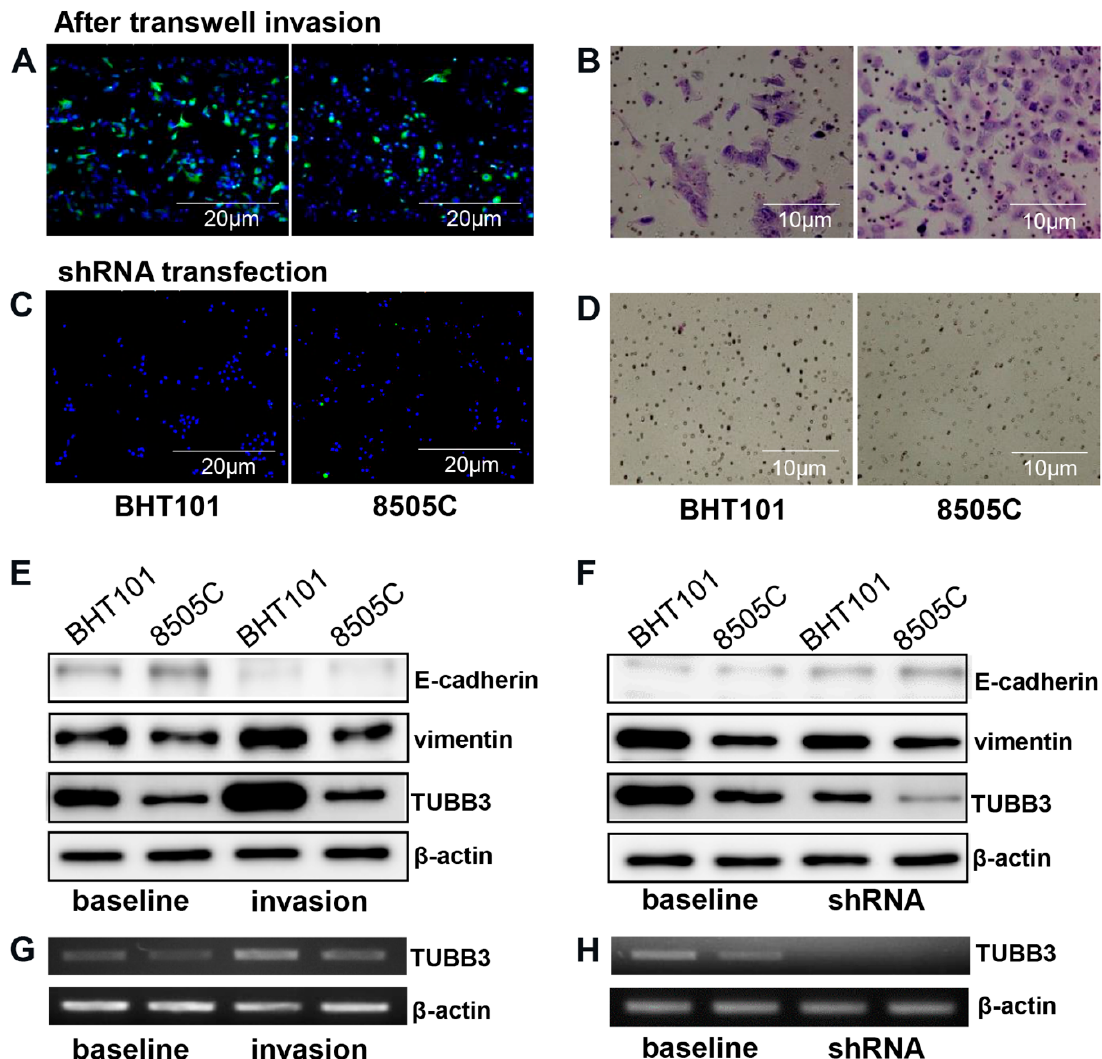
Figure 5. Transwell invasion assay and shRNA transfection. ( A , C ) Immunofluorescent and ( B , D ) Giemsa staining revealed reduced invasion activity of ATC cells after shRNA transfection. ( E ) Western blot revealed increased vimentin and TUBB3 expression and decreased E-cadherin expression after transwell invasion compared with baseline. ( G ) RT-PCR also revealed increased TUBB3 expression after transwell invasion. ( F ) Western blot after shRNA transfection showed decreased vimentin and TUBB3 expression and increased E-cadherin expression compared with baseline. ( H ) RT-PCR also revealed decreased TUBB3 expression after shRNA transfection.